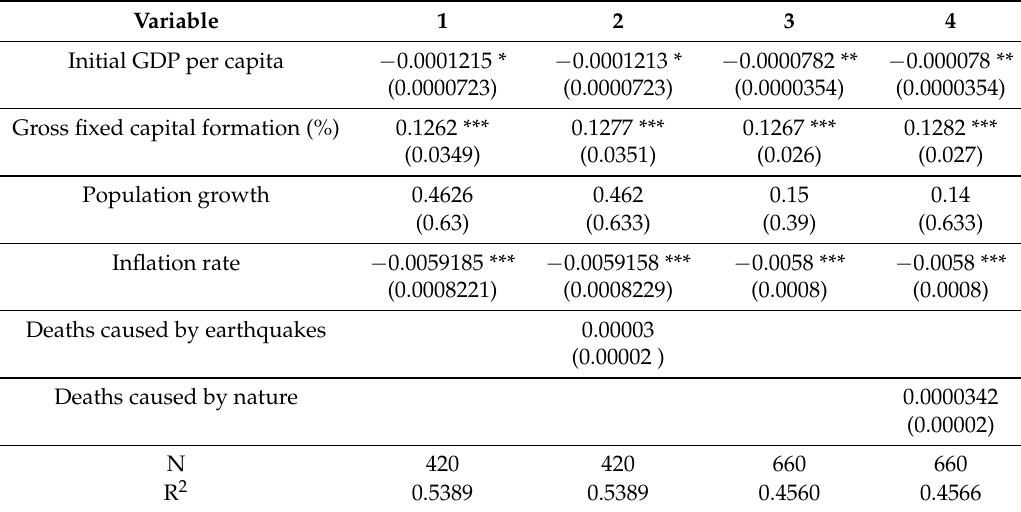
Table 2. Estimated results from parametric panel data models with fixed